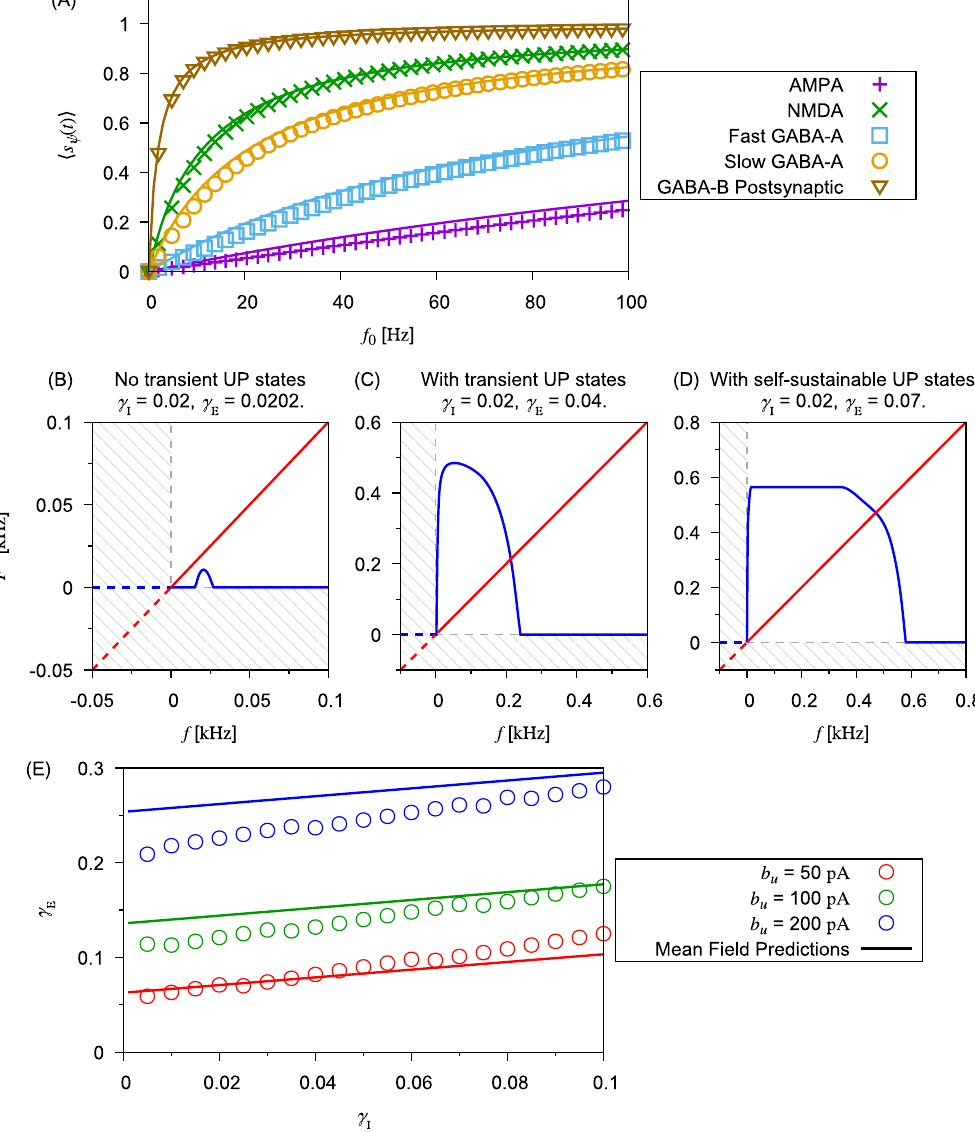
Figure 5. Mean-field analysis of UP-DOWN transition. ( A ) The frequency response of gating functions of different synapses is calculated by numerical simulations of the network models (symbols). Curves represent the predictions by Eq. (14). ( B – D ) Schematic illustrations of the mean-field analysis quoted in Eq. (18) with parameters for different scenarios. Blue curves: function F ′ defined in Eq. (18) as a function of f . Red curves: self-consistent constraint. Shaded areas: regions for negative frequencies. ( E ) Comparisons of critical γ E for sustainable UP states between predictions by mean-field analysis and simulations for given γ I ’s at different SFA